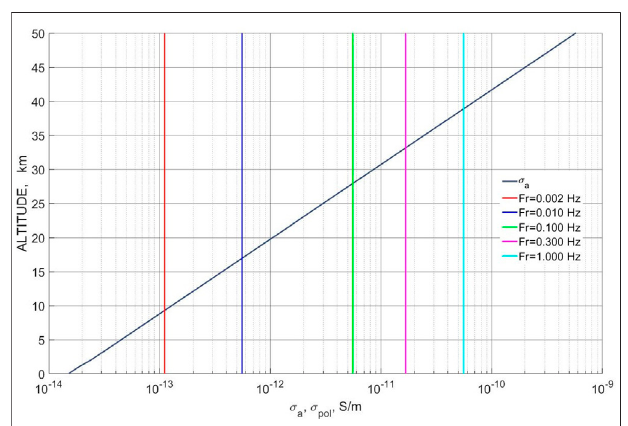
FIGURE 3 | The altitude dependence of the absolute magnitude of the atmospheric conductivity | σ A ( z )| (black line). The magnitude of the displacement current εε 0 ω for frequencies from 2 mHz to 1 Hz is denoted by vertical